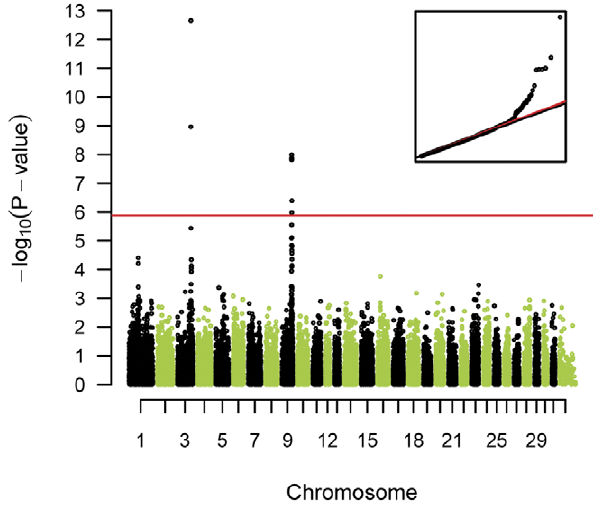
Figure 2. Manhattan plot for height at withers based on dEBV. The red line indicates the Bonferroni-corrected significance level (p , 1.31 6 10 2 6 ). The inset shows a quantile-quantile (qq) plot with the observed plotted against the expected p-values. The used mixed- model approach efficiently corrected for the stratification in the sample. The skew at the right edge indicates that these SNPs are stronger associated with height than would be expected by chance. This is consistent with a true association as opposed to a false positive signal due to population stratification.